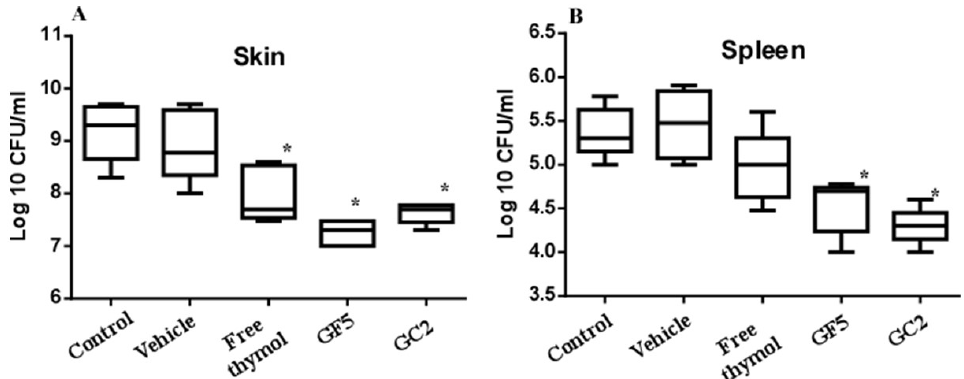
Figure 9. Effect of free thymol hydrogel, GF5, and GC2 on S. aureus murine skin infection. ( A ) Box plot of the bacterial burden recovered from skin lesions of mice. ( B ) Box plot of the bacterial burden recovered from the spleen. Statistical analysis was performed using GraphPad Prism (version 6.0) (GraphPad Software, Inc., USA), applying the one-way ANOVA, followed by Dunnett’s multiple comparisons test. Error bars represent the standard error. The * indicates significant difference at p value ≤ 0.05, compared to control group.